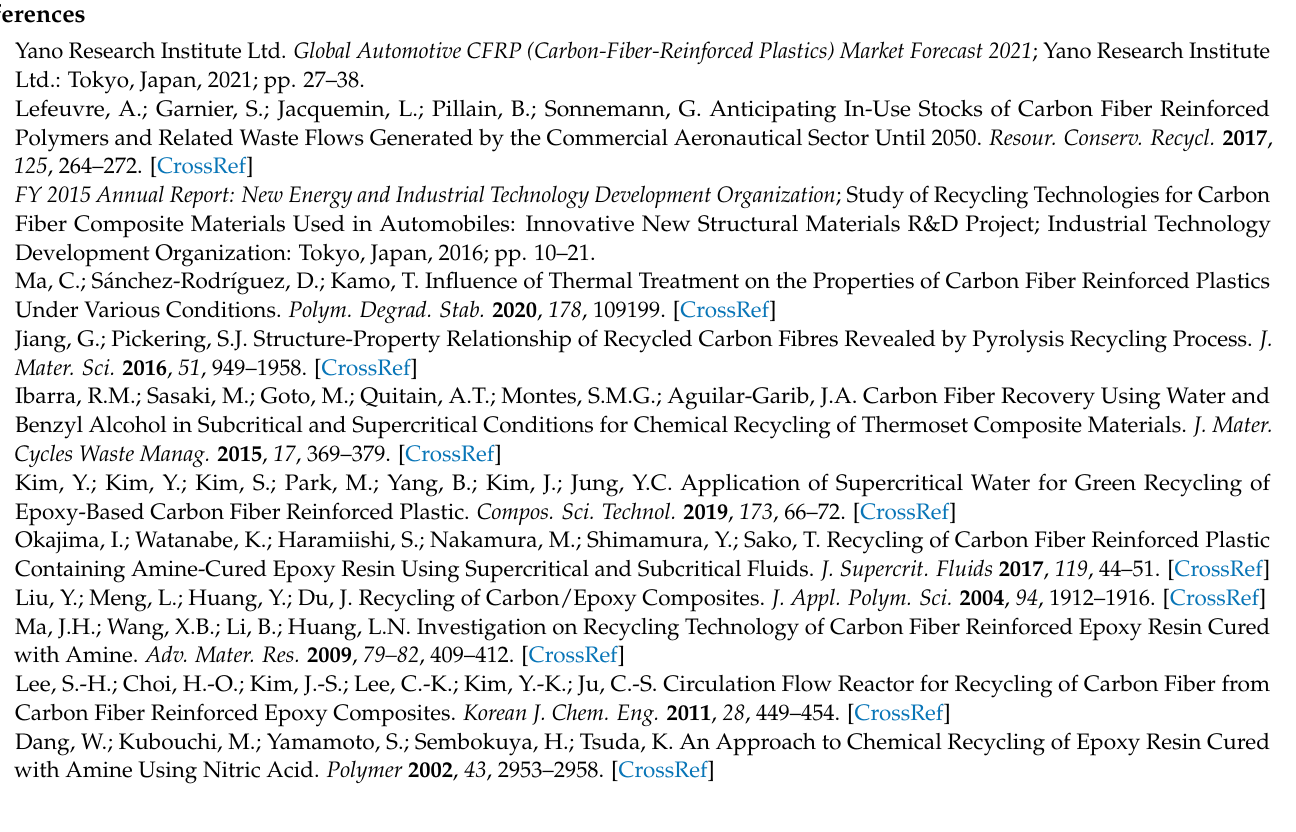
Figure A6. ( a ) Raman normalized spectra of the vCF and rCF surfaces using a 532 nm laser measured under 0.2 mW; ( b ) curve fitting results of Raman normalized spectra for vCF.